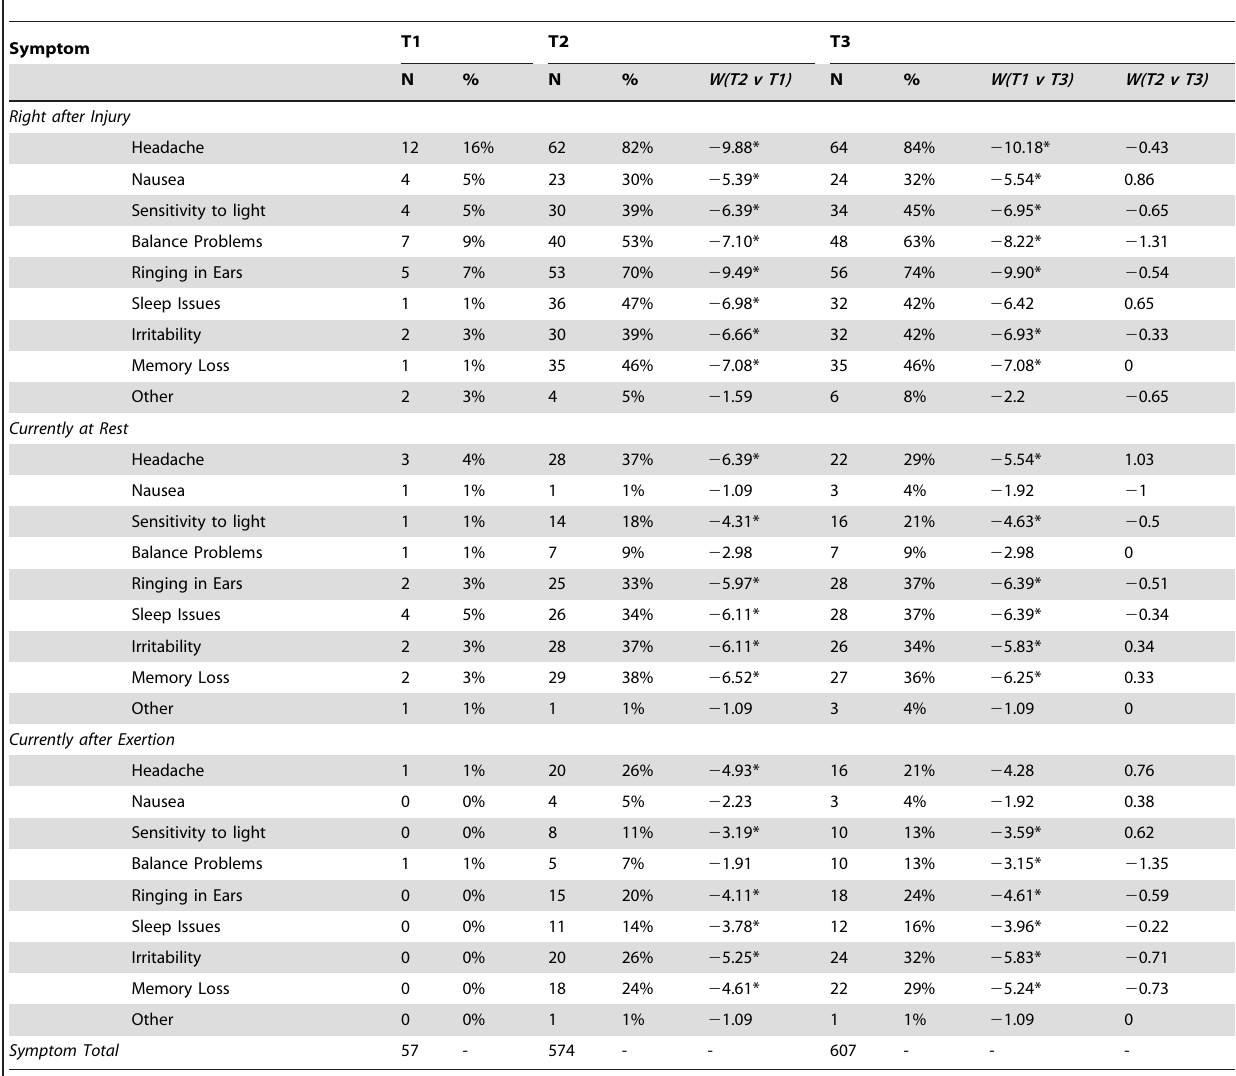
Table 3. ANAM4 TBI-MIL Questionnaire and ACSI Symptomology for Concussed Service Members (N=76).